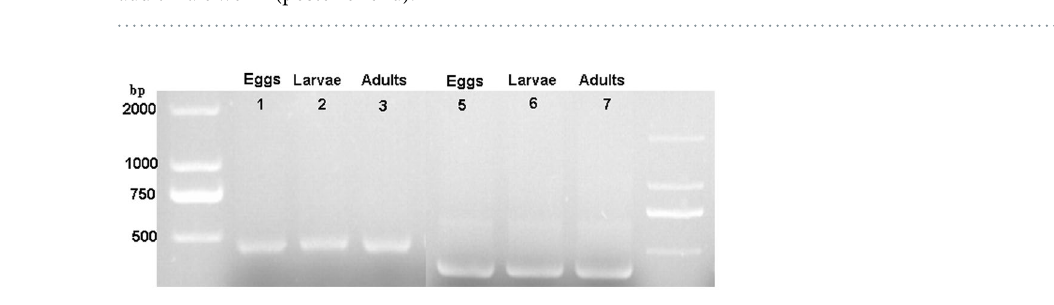
Figure 2. GoldViewTM Nucleic Acid Stained 1.5% Agarose gel of V3-V4 region of 16S RNA gene sequence (1, 2 and 3) and V5-V7 region of 16S RNA gene (4, 5 and 6) amplified product of eggs, L 3 larvae and adults of H. contortus. Lane 1 and 8: Direct-load ™ Star Marker Plus (D2000 Plus); GenStar Biosolutions Co. Ltd, Beijing,